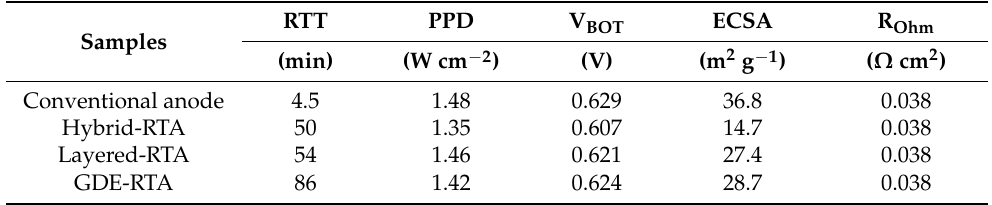
Table 3. Electrochemical data analysis and voltage decay rate of aged MEAs.